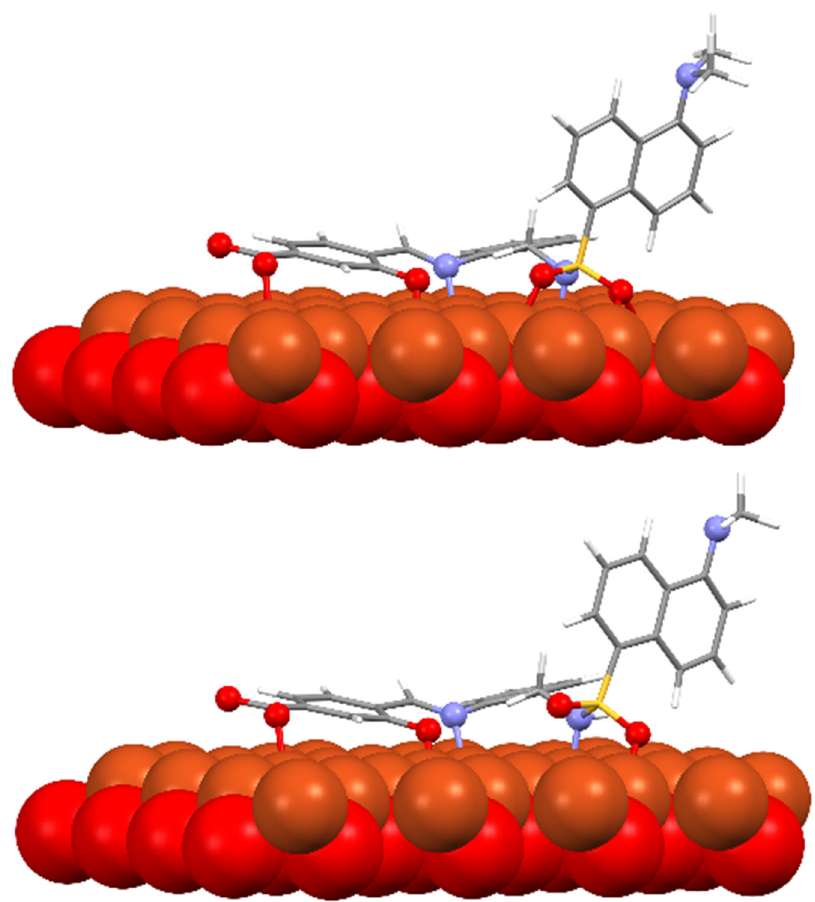
Figure 12. DFT models for the interaction H 3 L-NPs.